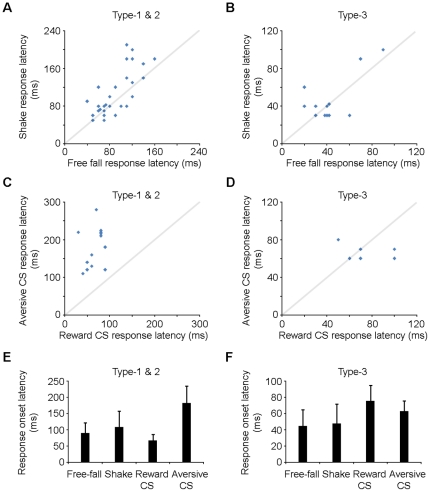
Response onset latencies of the VTA putative dopamine neurons.(A) Response onset latencies of individual type-1 and 2 dopamine neurons to free fall and shake events. (B) Response onset latencies of individual type-3 dopamine neurons to free fall and shake events. (C) Response onset latencies of individual type-1 and 2 dopamine neurons to the reward CS that predicted sugar pellet and the aversive CS that predicted free fall. (D) Response onset latencies of individual type-3 dopamine neurons to the reward CS that predicted sugar pellet and the aversive CS that predicted free fall. (E) Population average response onset latencies of type-1 and 2 dopamine neurons (from the same data as shown in A and C) and (F) type-3 neurons (from the same data as shown in B and D). Response onset latencies for type-1/2 neurons to free fall, shake and aversive CS correspond to the latencies of suppression; while the others correspond to the latencies of activation. Error bars, s.d.